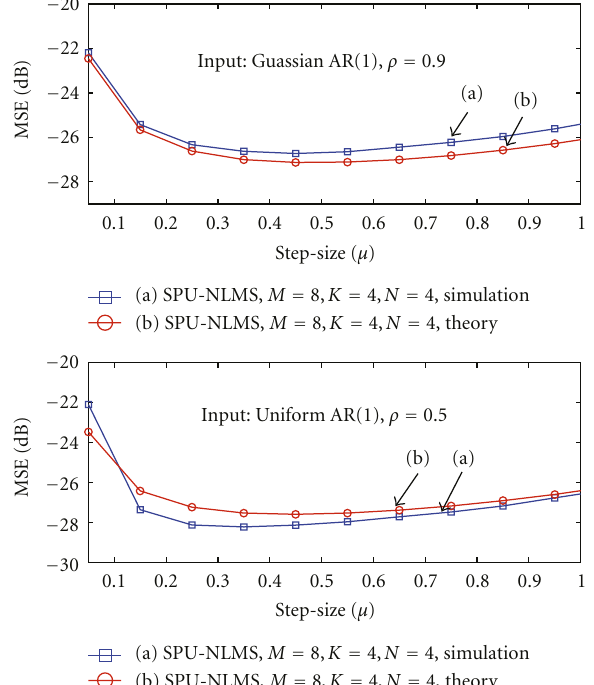
Figure 10: Steady-state MSE of SPU-APA with M = 8, P = 4, K = 4 and N = 3 as a function of the step size in